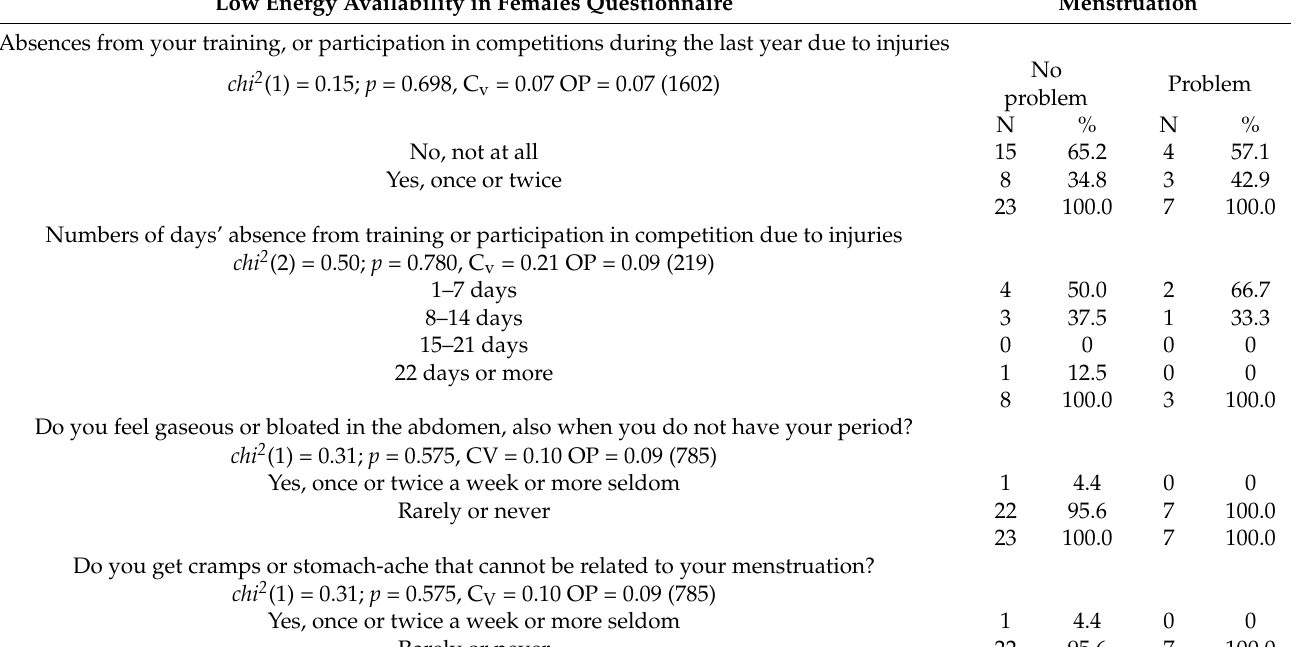
Table 2. LEAF-Q results. OP: observed power. Numbers in parentheses: N needed for power = 0.8. Low Energy Availability in Females Questionnaire